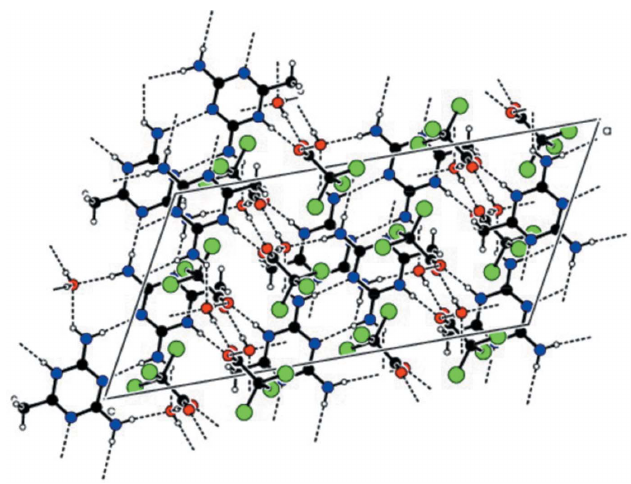
Figure 4 An overall view of the three-dimensional hydrogen-bonded supra- molecular structure.